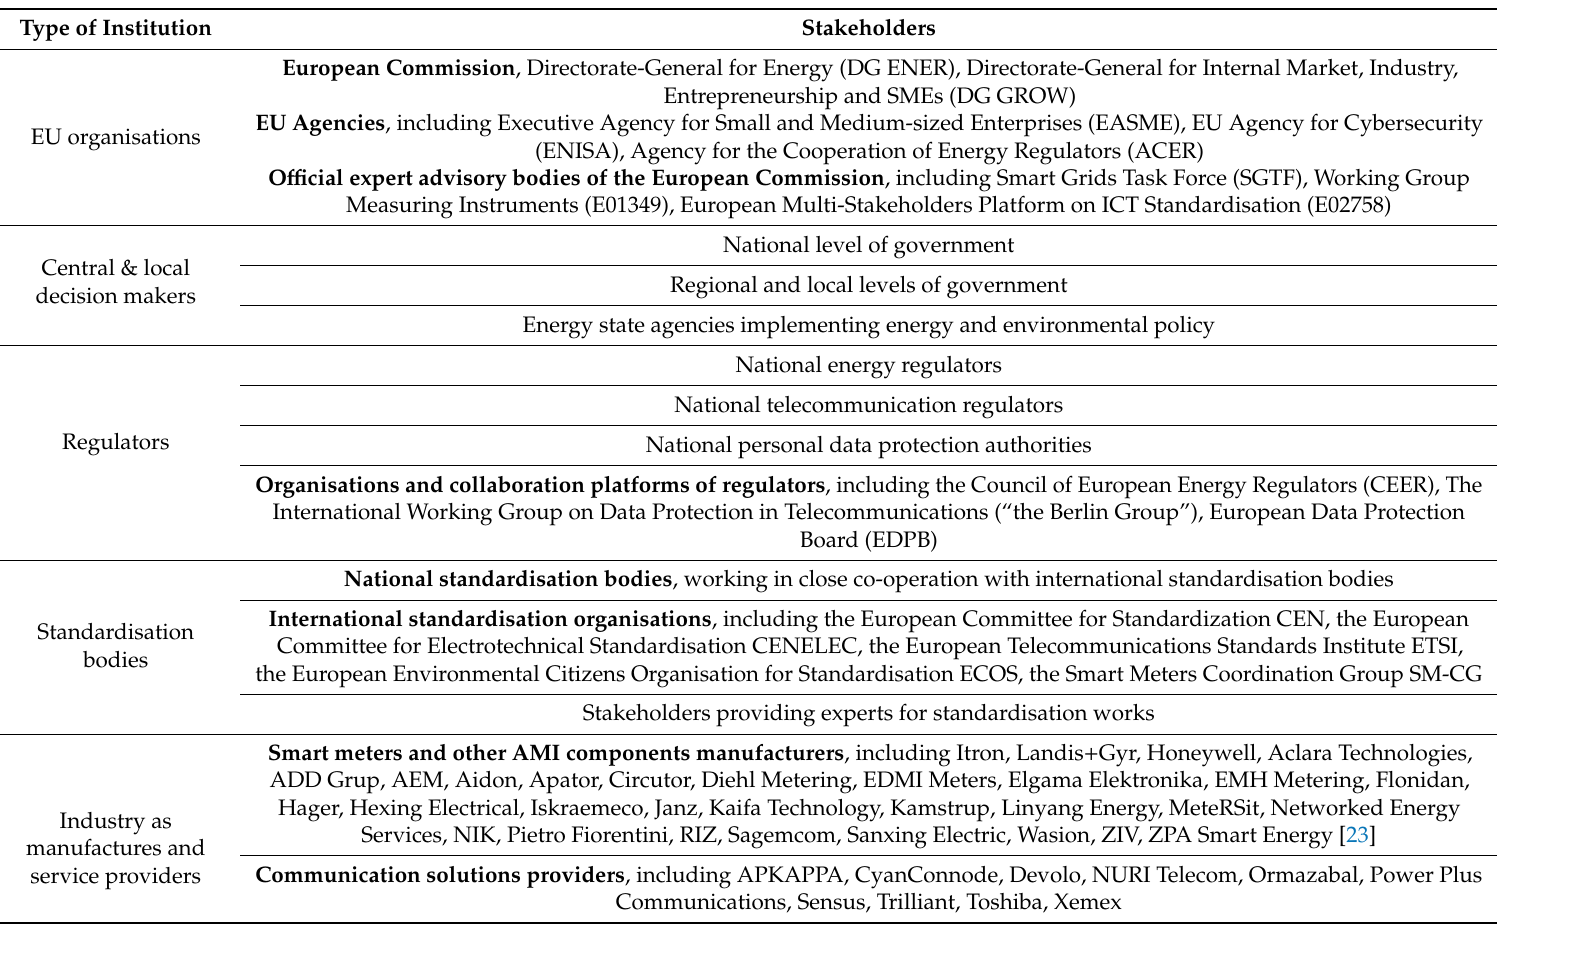
Table 2. Inventory of the main stakeholders in smart metering projects in the EU (Authors’ work based on